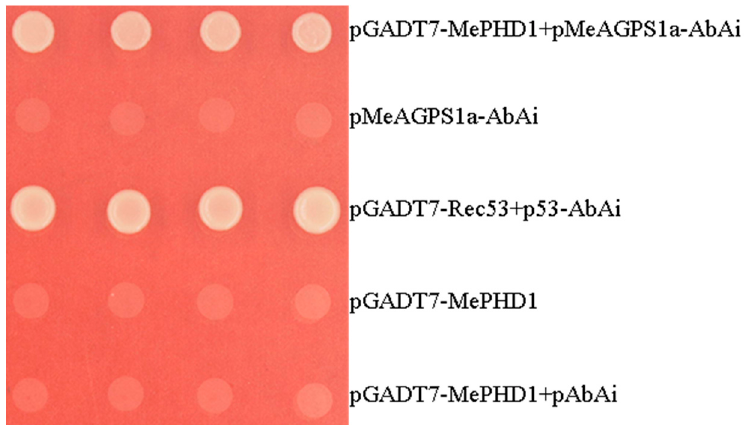
Figure 1. Activation of MeAGPS1a promoter, in yeast, by MePHD1. pGADT7-MePHD1 + pMeAGPS1a-AbAi is the experiment, pMeAGPS1a-AbAi is the empty vector control, pGADT7-Rec53 + p53-AbAi is the positive control, pGADT7-MePHD1 and pGADT7-MePHD1 + pAbAi are the negative controls. Yeast cells were grown in SD/-Leu selective medium, containing 300 ng/mL Aureobasidin A (AbA), for 3 days, at 30 °C.